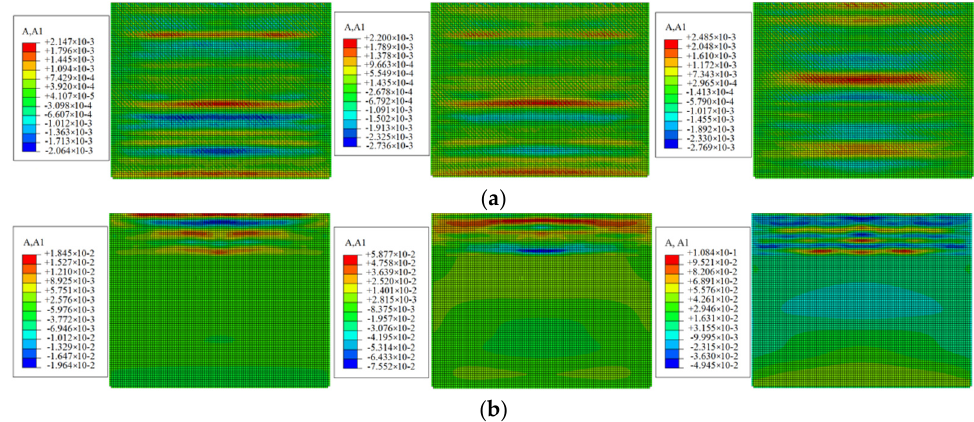
Figure 8. Acceleration distribution during wave propagation in Model 1 when the WE wave is input in the x direction: ( a ) Model 1 (t = 1.80 s; t = 1.95 s; t = 2.05 s), ( b ) Model 2 (t = 1.95 s; t = 2.15 s; t = 2.30 s). (Unit: m/s 2 ).